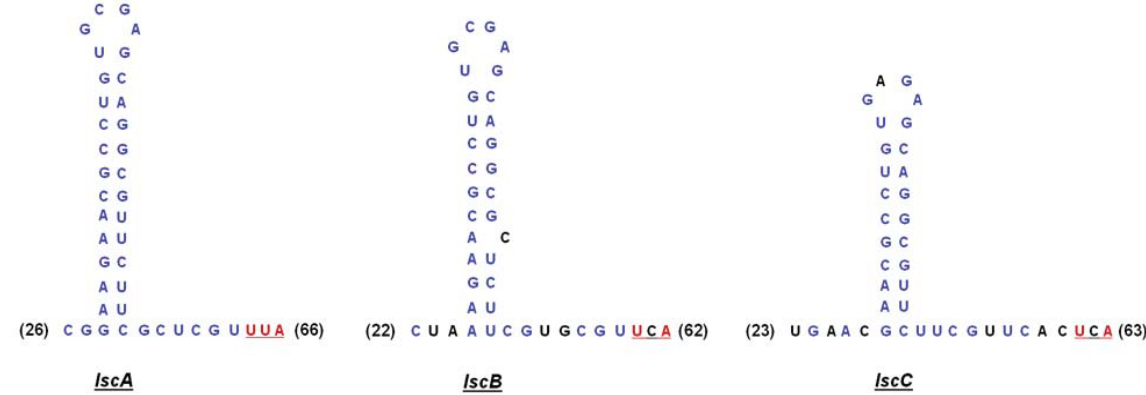
Figure A3. Schematic depiction of predicted stem loop structures at the mRNA level for lscA, lscB , and lscC transcripts. The poly U runs suggest ρ -independent transcriptional termination. Blue nucleotide letters were found identical to those of the lscA downstream sequence. Red letters symbolize the position of the stop codon of nasT gene in case of lscA .